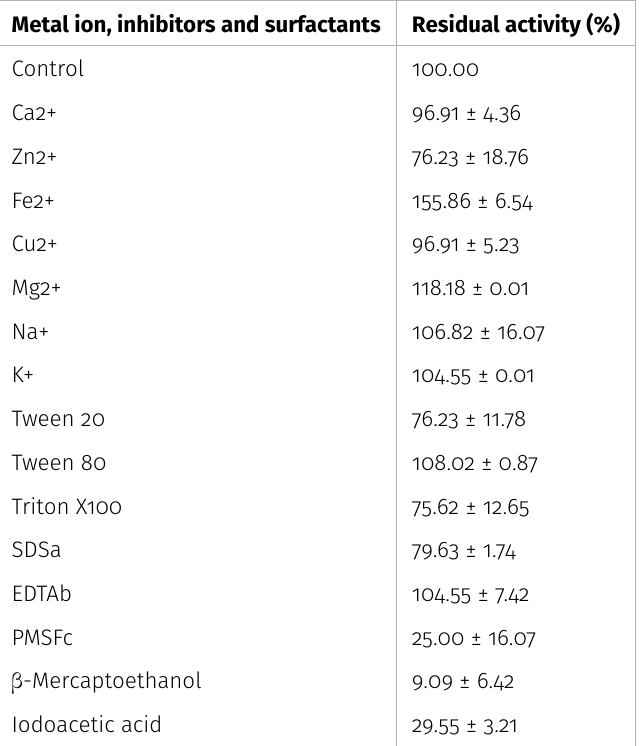
Table IV. Effect of metal ions, protease inhibitors and surfactants on the enzyme activity.